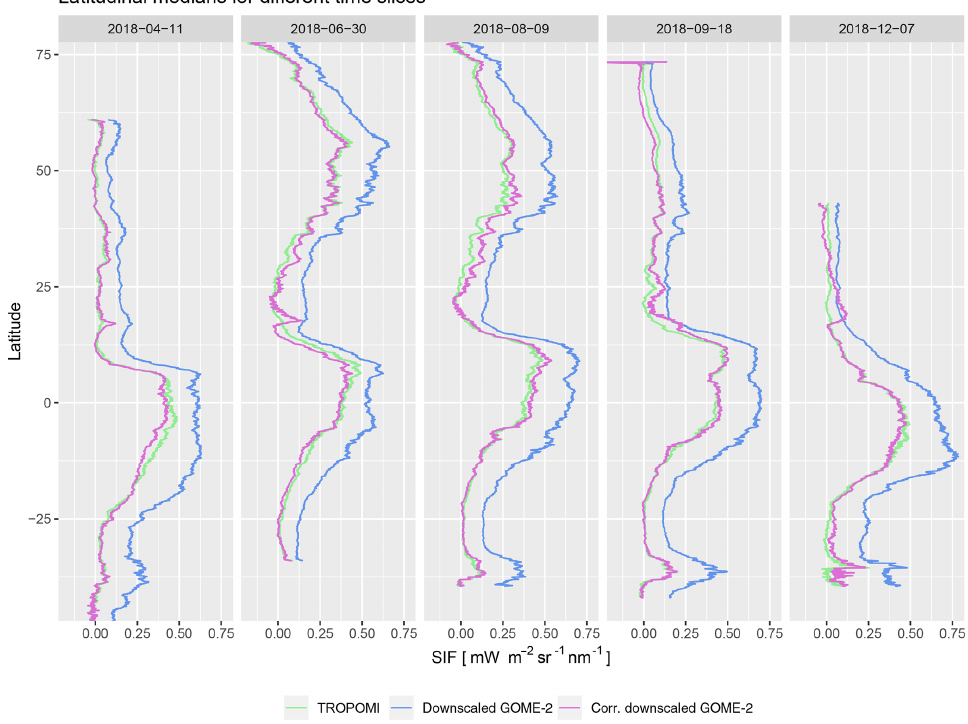
Figure 7. Comparison of latitudinal profiles of TROPOMI SIF, downscaled GOME-2 PK SIF, and the same downscaled GOME-2 SIF but bias-corrected based on the slope and intercept obtained at pixel level over the overlapping time